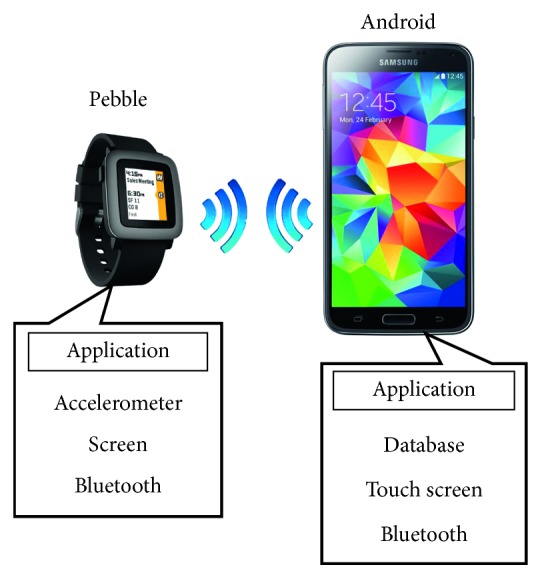
System architecture.